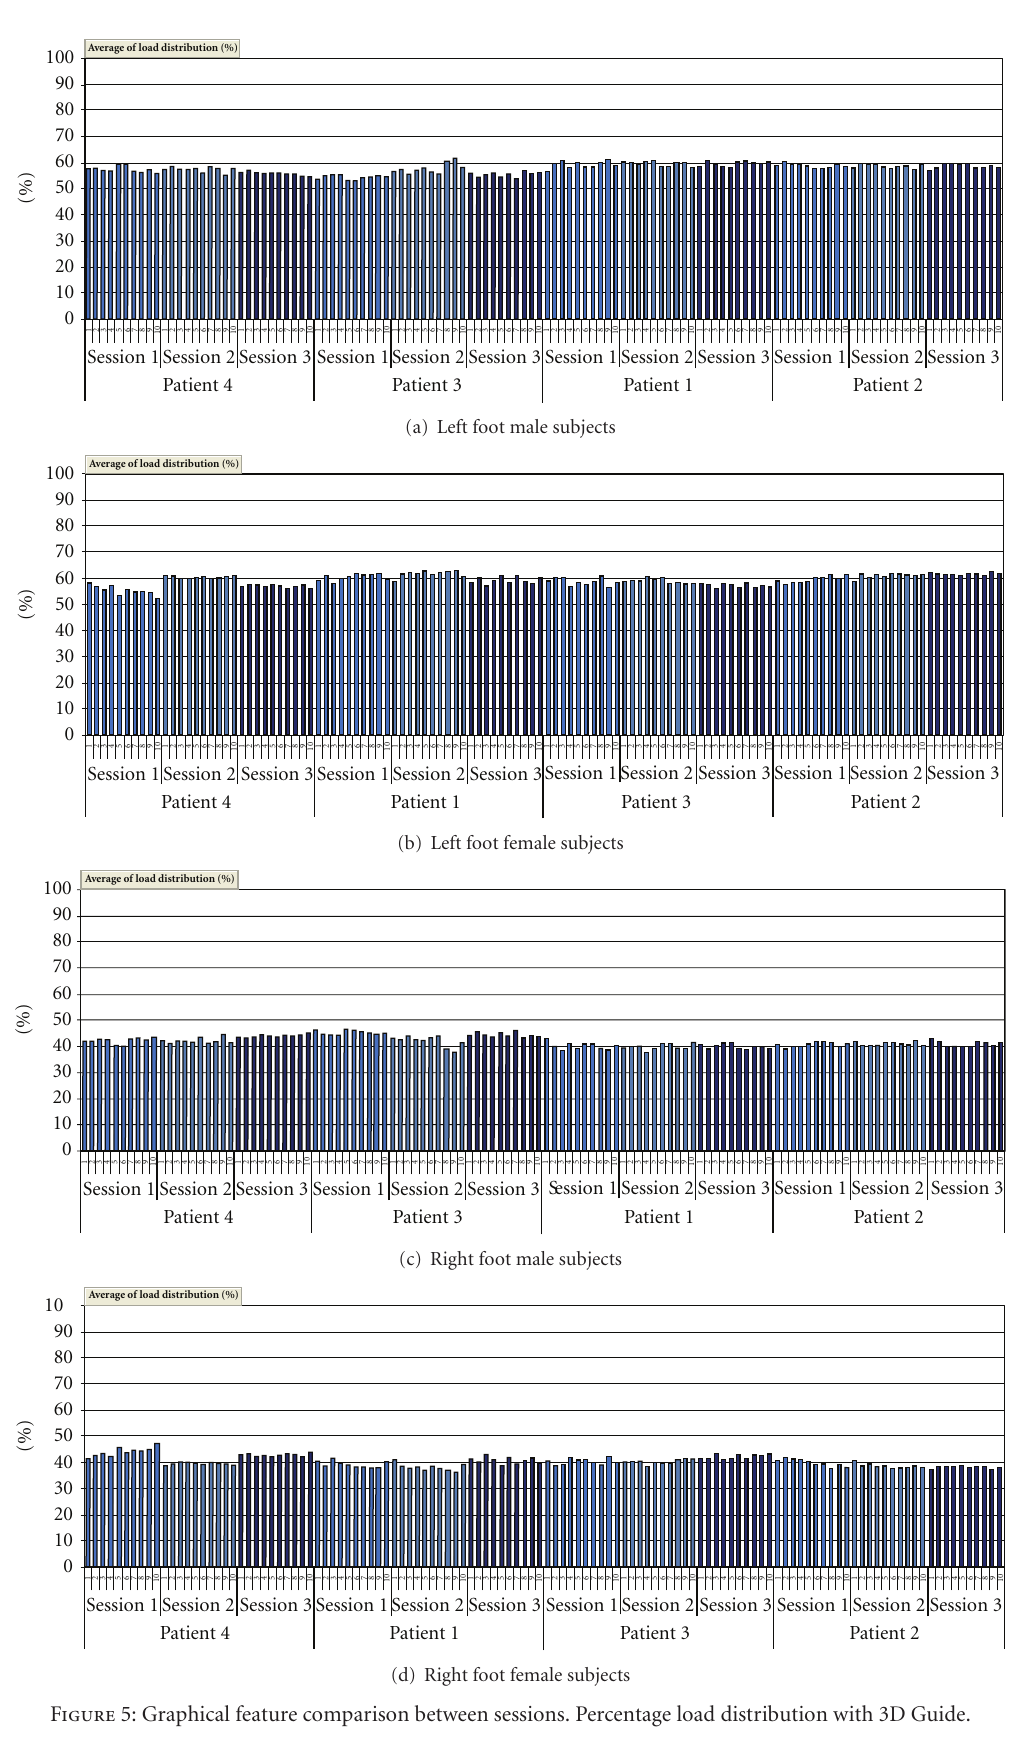
Figure 5: Graphical feature comparison between sessions. Percentage load distribution with 3D